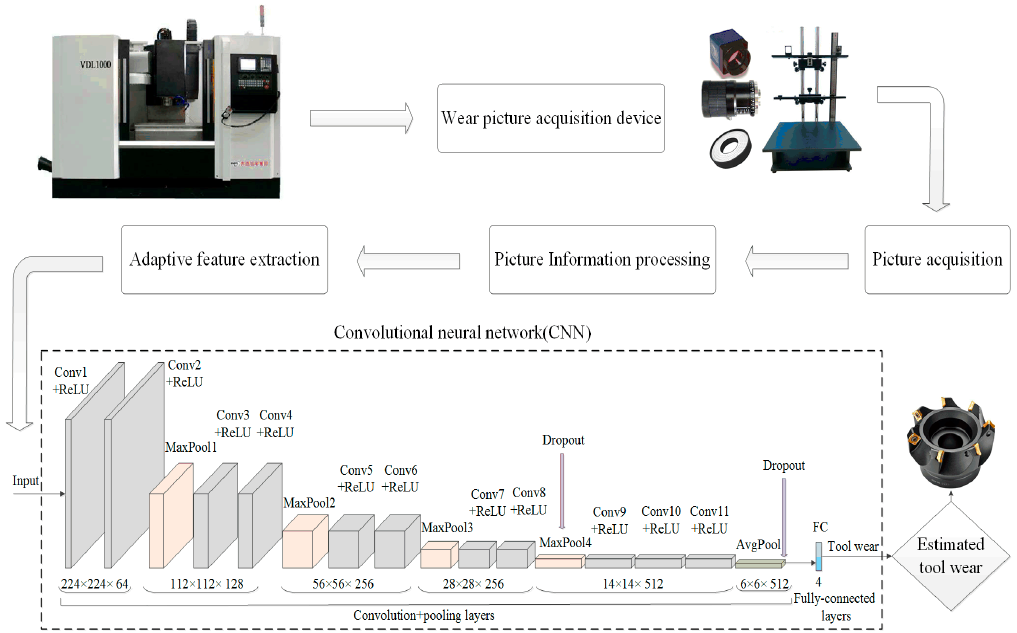
Figure 4. The framework of wear type identification method and network structure based on CNN.